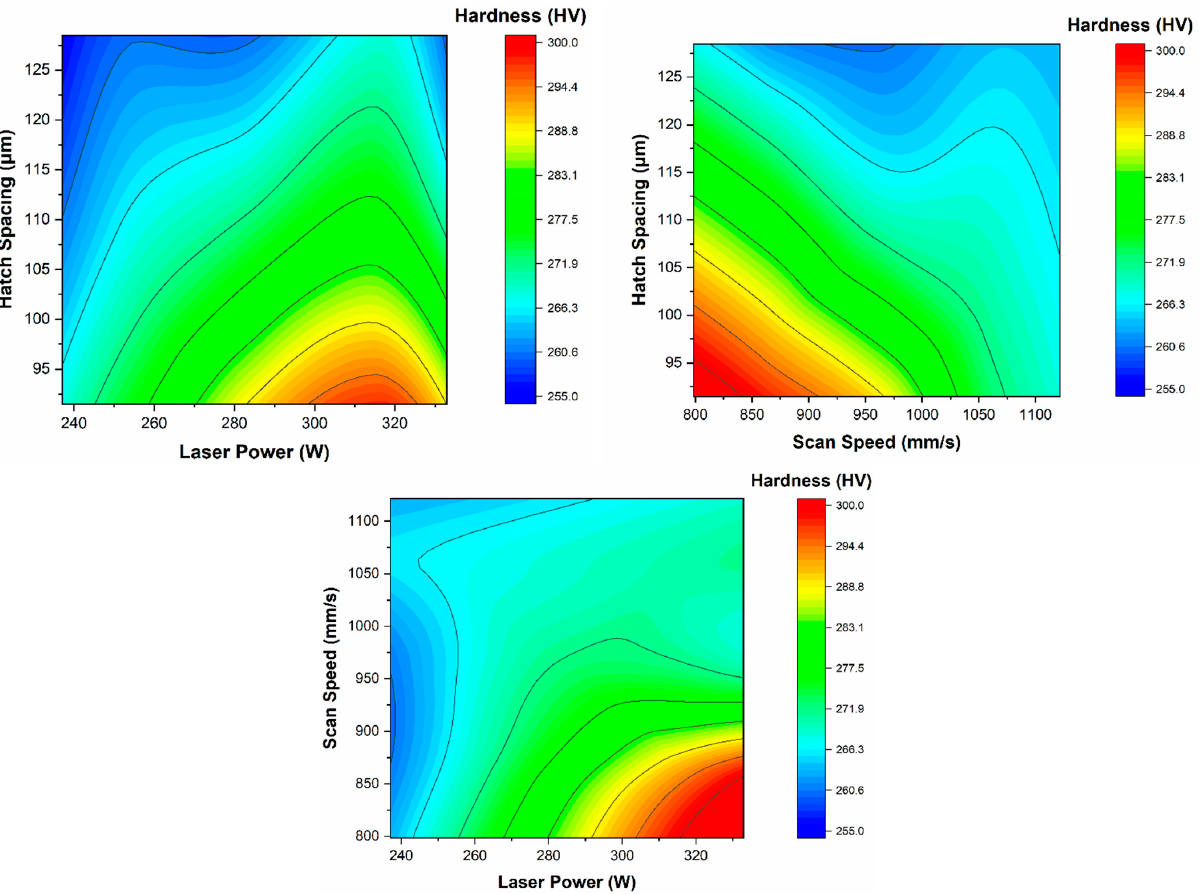
Figure 3. The influence of processing parameters on the surface hardness of the SLM-fabricated IN718 samples.